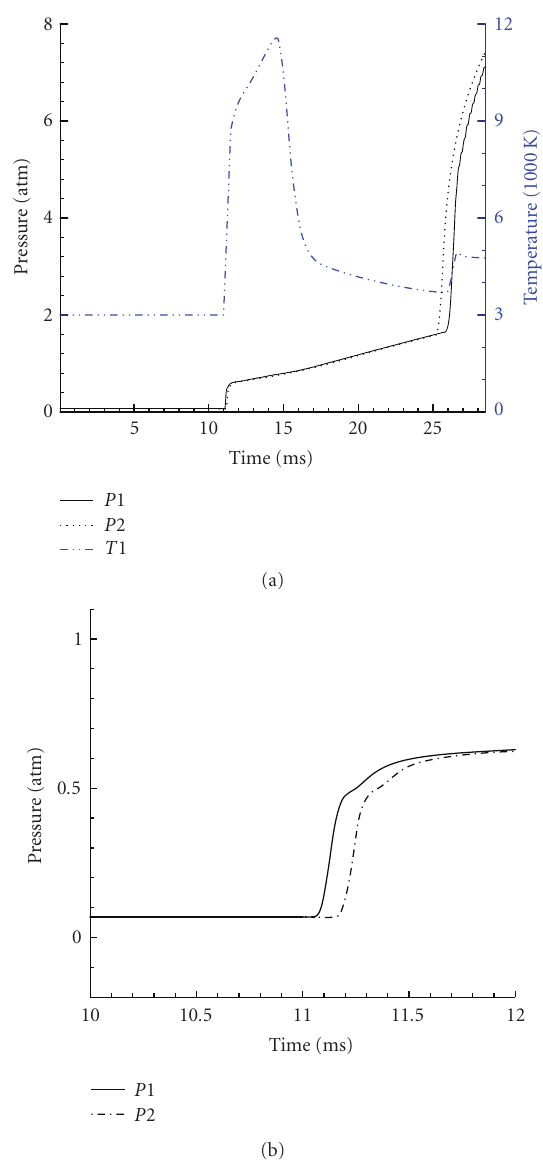
Figure 4: Pressure and temperature profile at point no. 1 and no. 2.